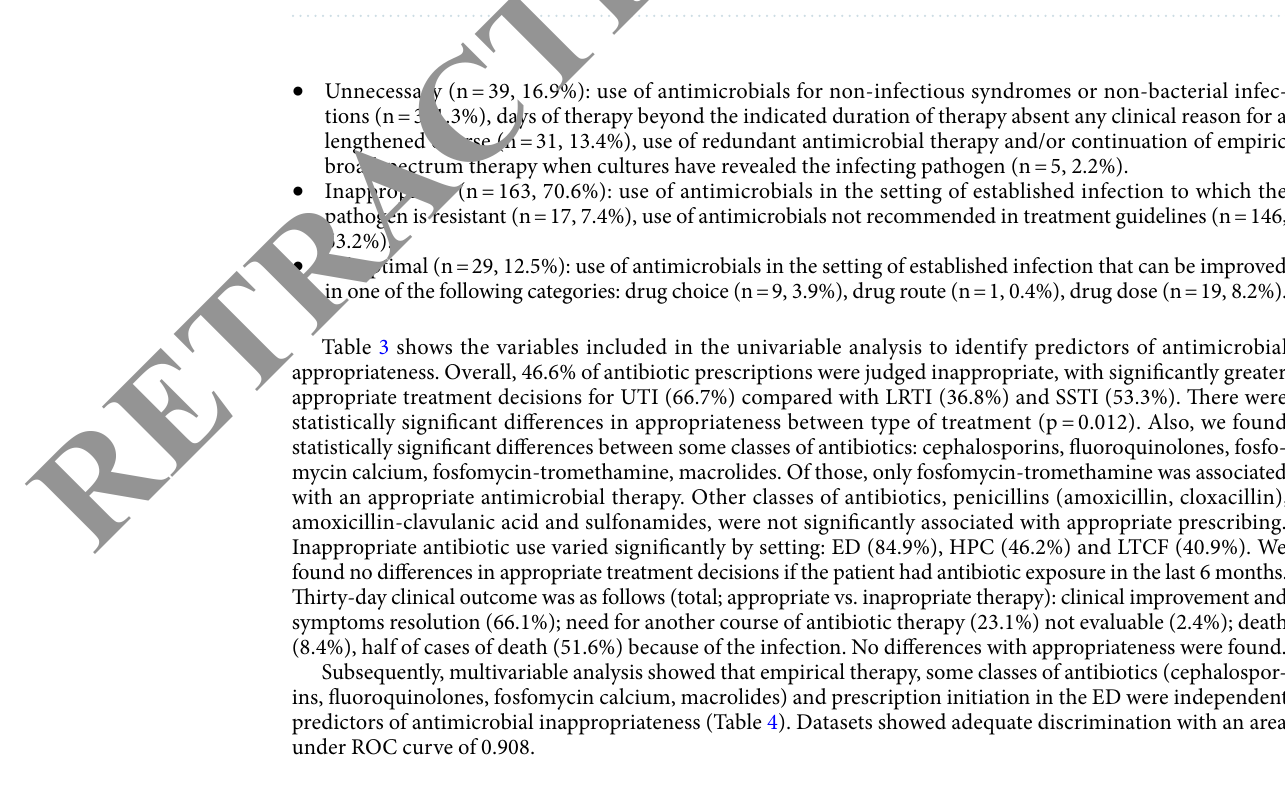
Table 3. Univariable analysis of variables associated with appropriateness. IQR: interquartile range; LRTI: lower Respiratory Tract Infections; LTCF: long-term care facility; SD: standard deviation; SSTI: skin and Soft Tissue Infections; UTI: urinary Tract